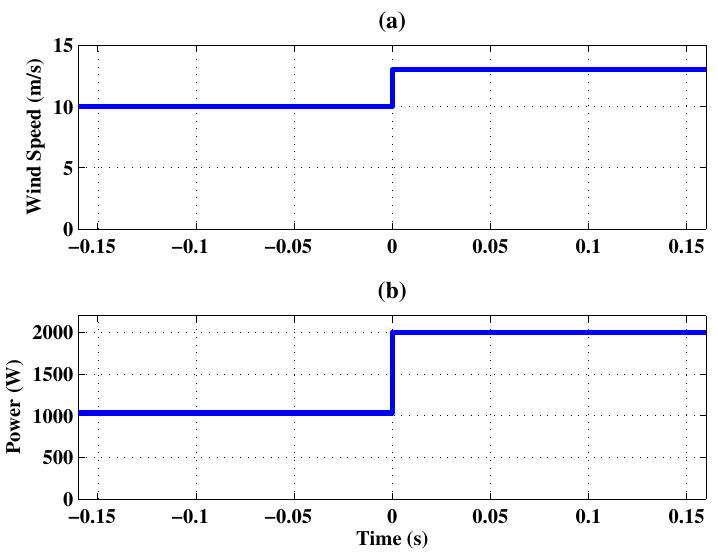
Figure 3. Step in change in ( a ) wind speed and ( b ) power available from the wind, implemented in both simulation and hardware-in-the-loop.